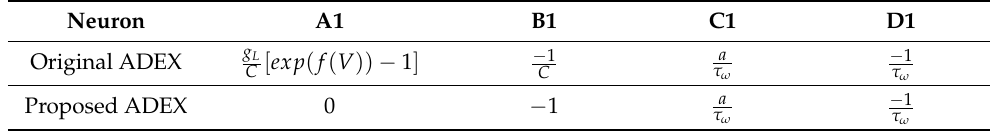
Table 3. The Jacobean matrix equations for two ADEX models (original and proposed).